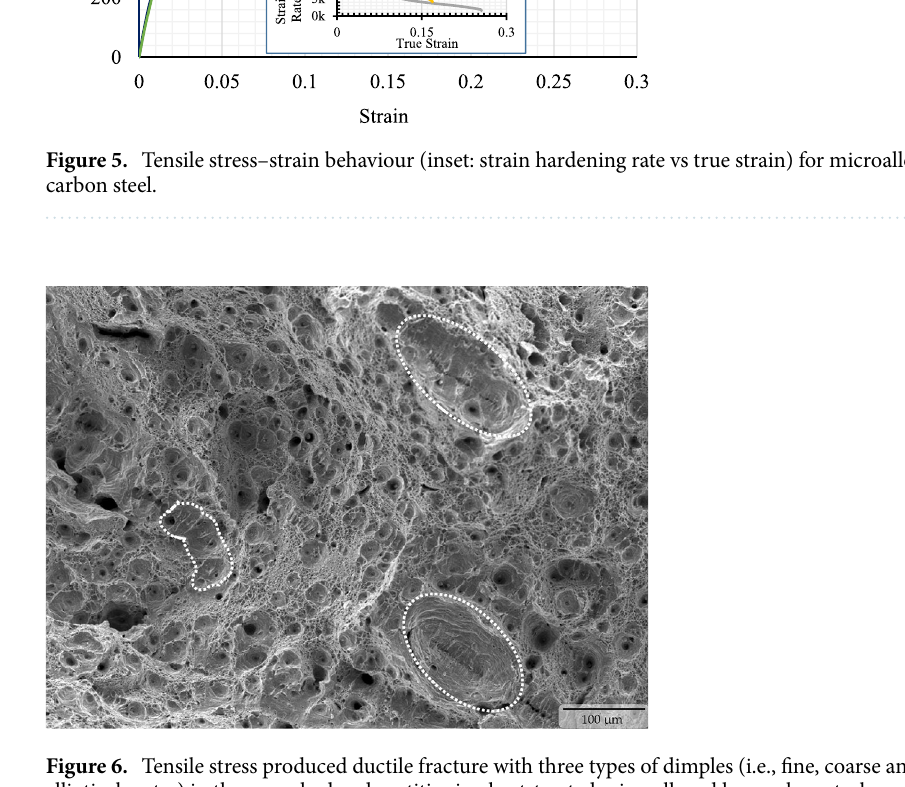
Figure 6. Tensile stress produced ductile fracture with three types of dimples (i.e., fine, coarse and large elliptical crater) in the quenched and partitioning heat-treated microalloyed low carbon